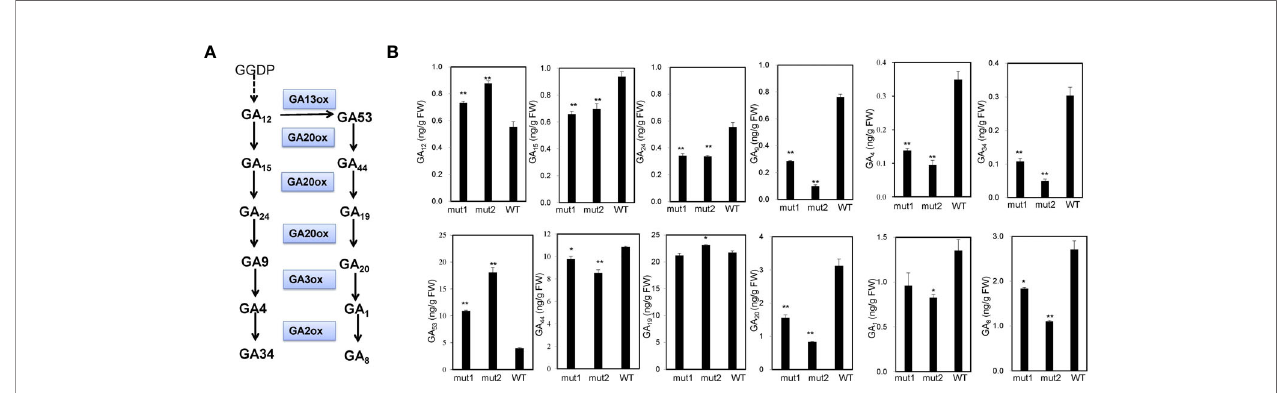
FIGURE 4 | GA contents in mutant and WT plants. (A) Diagram of the GA synthesis pathway. (B) Endogenous contents of GA 12 , GA 15 , GA 24 , GA 9 , GA 4 , GA 34 , GA 53 , GA 44 , GA 19 , GA 20 , GA 1 , and GA 8 in the stem apices of 7-week-old plants. Experiments were repeated with three biological replicates. * indicates signi fi cant differences at P< 0.05 level; ** indicates signi fi cant differences at the P<